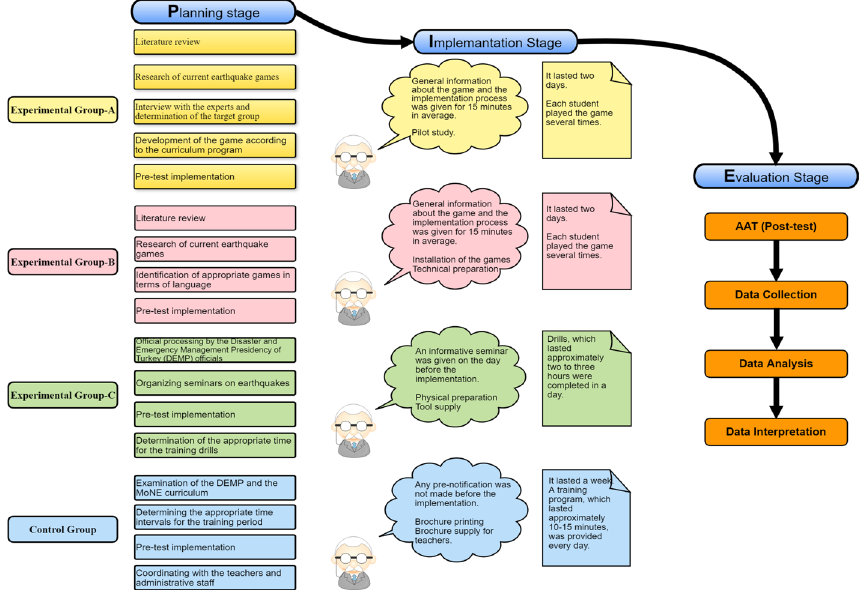
Fig. 1 Study process based on PIE model Experimental Group A—Study